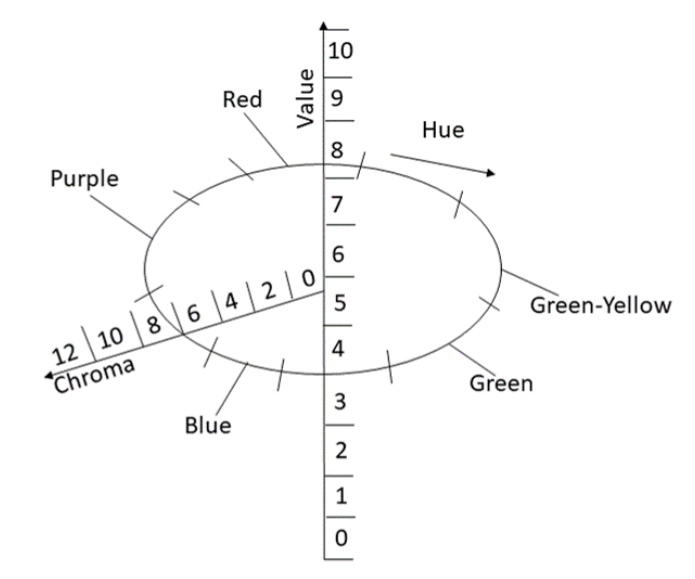
Figure 3. Munsell colour